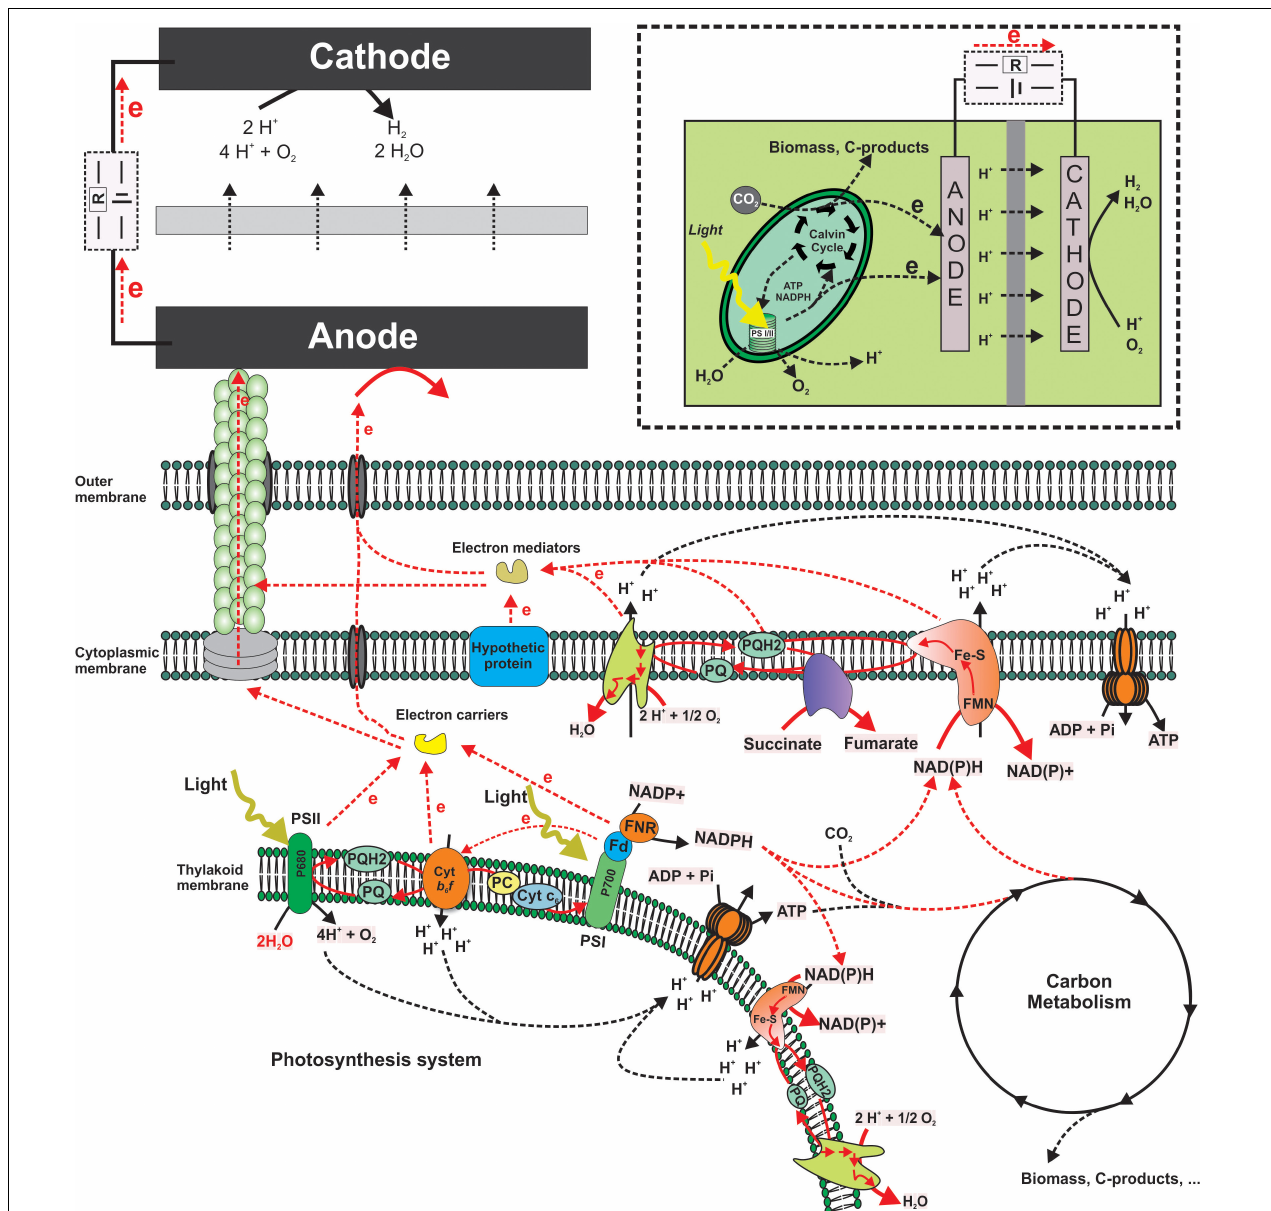
FIGURE 2 | Schematic of biophotovoltaics. Putative electron transfer pathways from the thylakoid membrane components (Photosystems) to an anode. This includes mediated electron transfer as well as hypothetical direct transfer via pili or other membrane structures. Red lines indicate hypothetical electron transfer routes. The insert on the upper right corner shows a schematic structure of a typical BPV